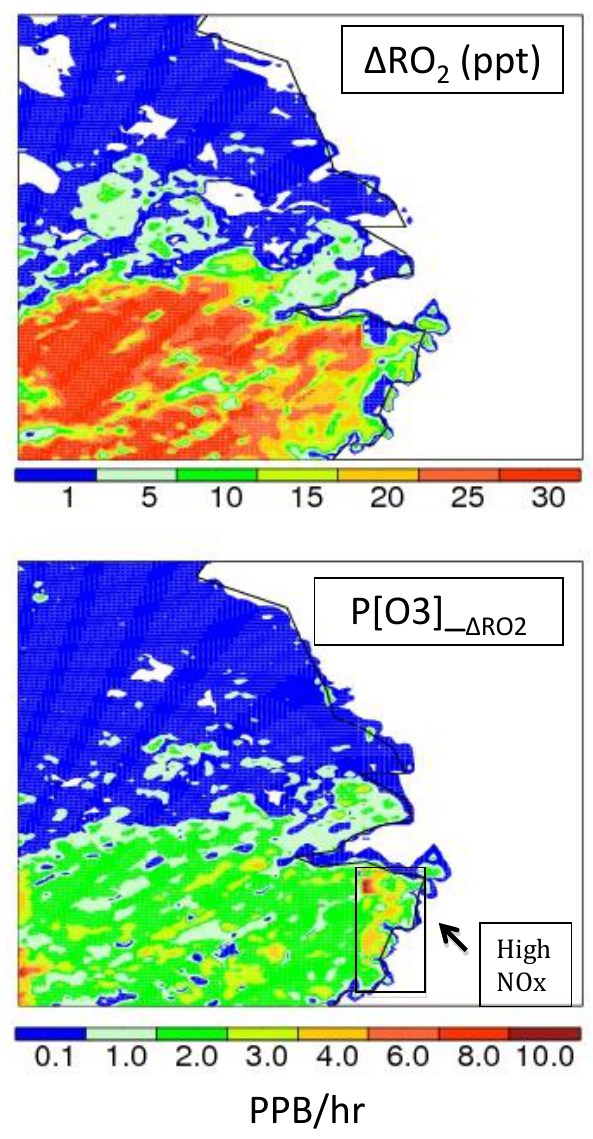
Fig. 8. Calculated increase of RO 2 concentrations (ppt, in upper panel) and the rate of ozone production due to the enhancement of RO 2 (ppbh − 1 , in lower panel) due to the biogenic emissions of isoprene in the forest areas at noontime of 12 July. The rectan- gle indicates the high NO x concentrations due to the anthropogenic emissions from large cities in the east coast